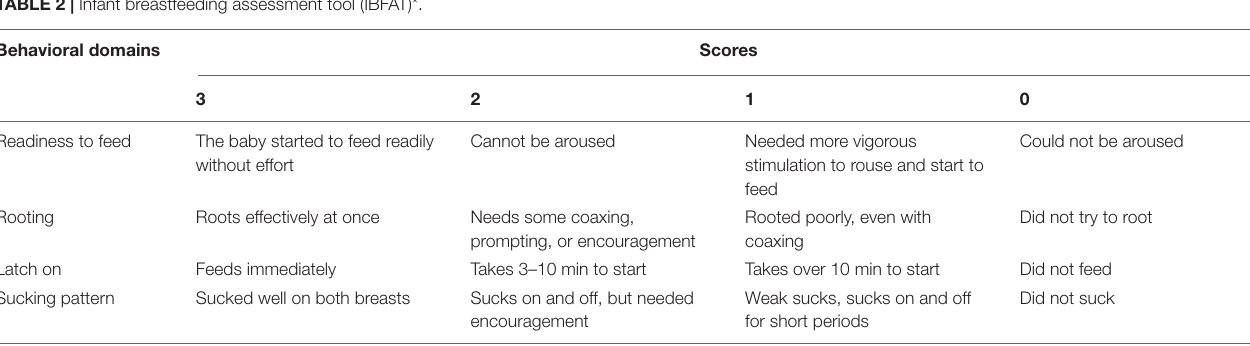
TABLE 2 | Infant breastfeeding assessment tool